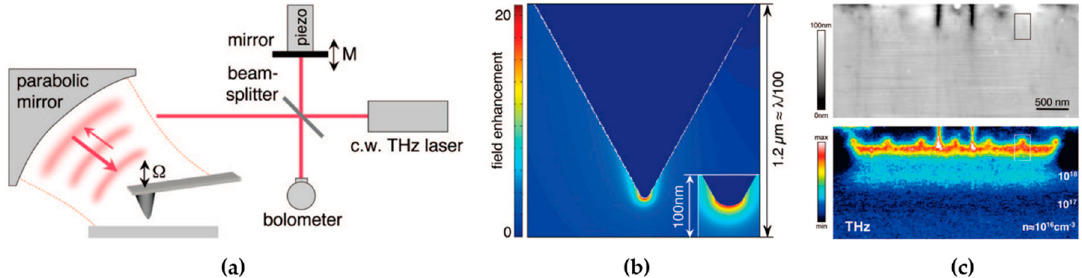
Figure 8. ( a ) s-SNOM setup using a THz CW laser at 2.54 THz; ( b ) electro-dynamical simulations of the FC for a standard AFM probe; and ( c ) the resulting AFM and THz image. Reprinted with permission from [128] .